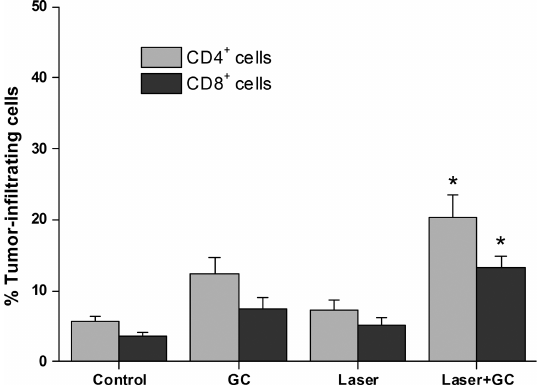
Fig. 4. Analysis of tumor-in¯ltrating CD4 þ or CD8 þ cells 7 days after di®erent treatments of mouse tumors. Treated tumors were excised, dissociated into single cell suspensions, labeled with FITC-conjugated anti-CD4 or phycoerythrin- conjugated anti-CD8 mAb, then analyzed by FACS. Bars, means (cid:2) SD ( n ¼ 4), * p < 0 :